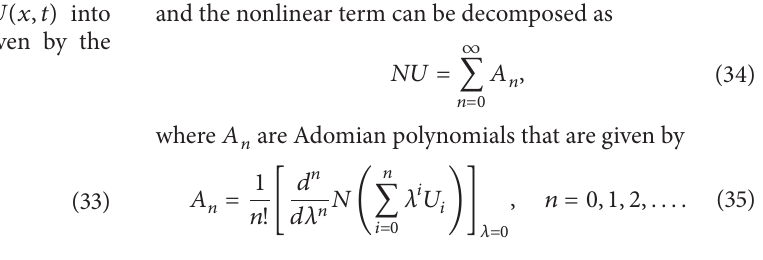
Next, we decompose the unknown function 𝑈(𝑥, 𝑡) into sum of an infinite number of components given by the decomposition